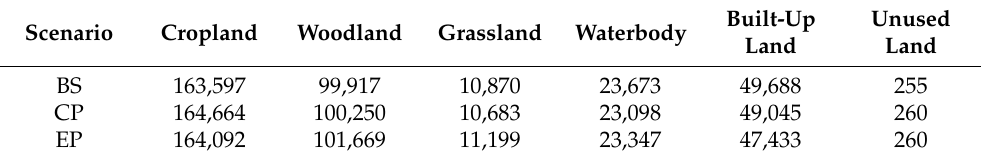
Built-Up Unused Land Land